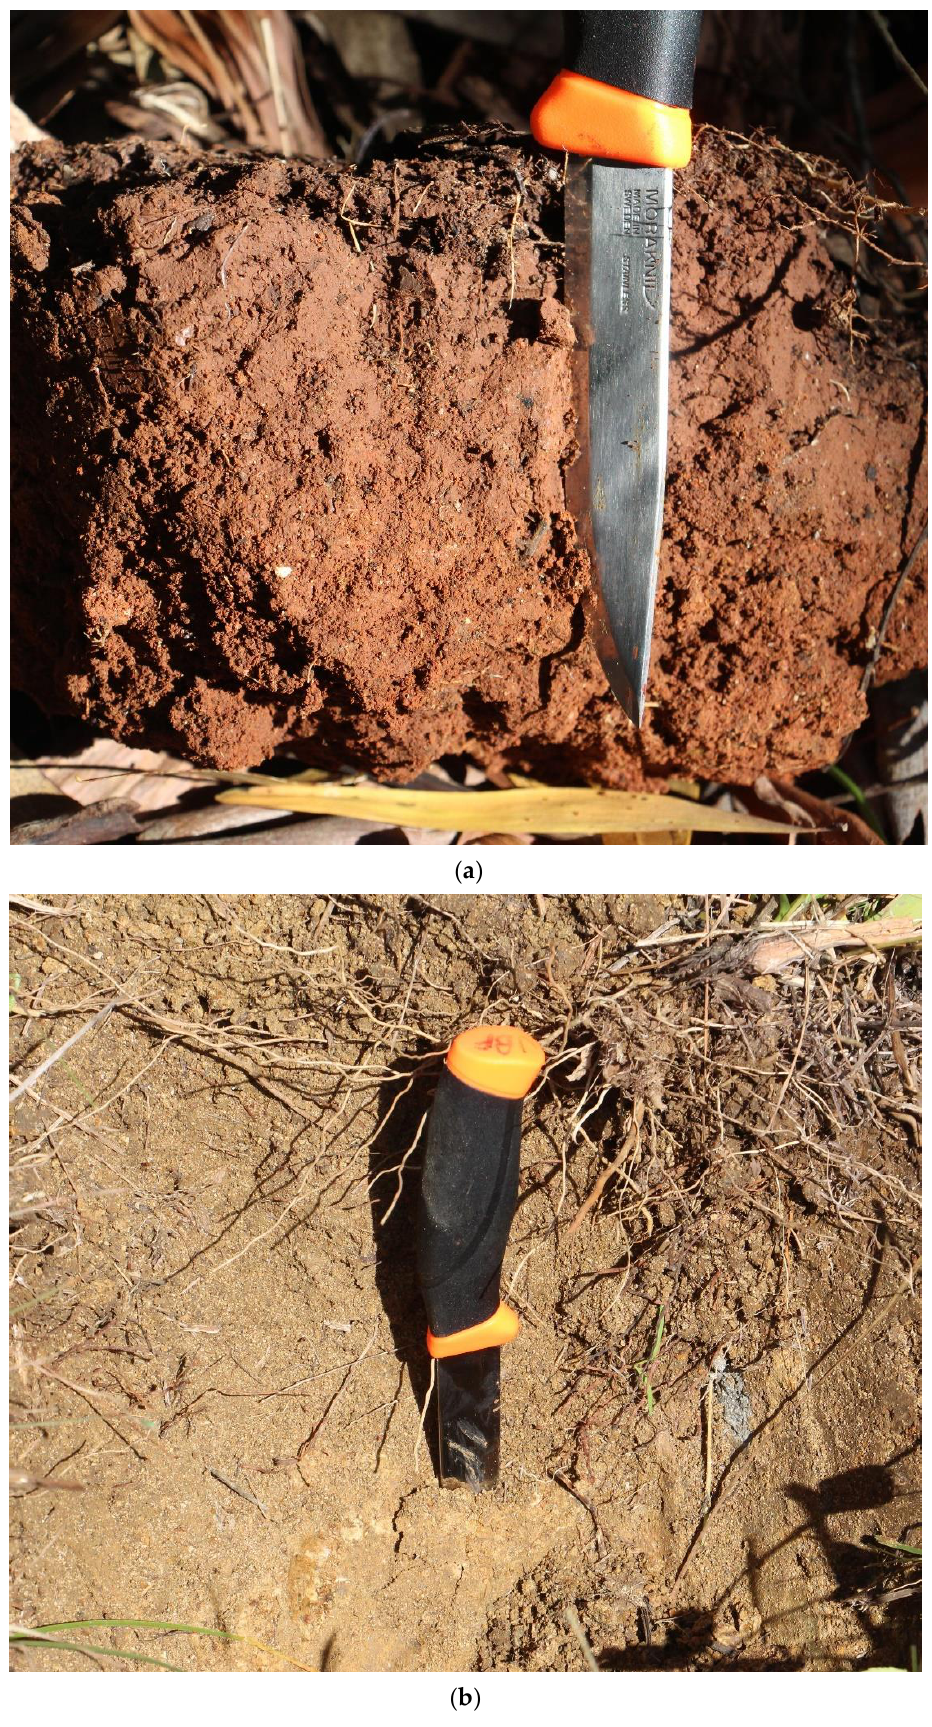
Figure 7. ( a ) Akina series soil and ( b ) Agfayan series soil, Guam.